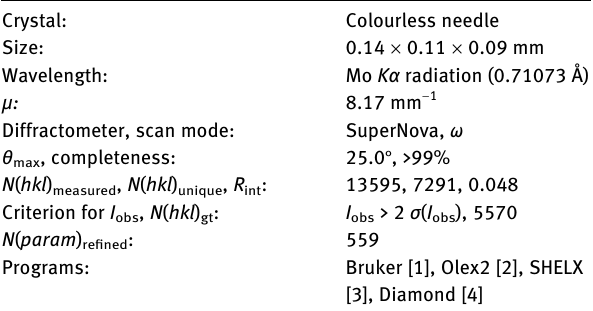
Table  : Data collection and